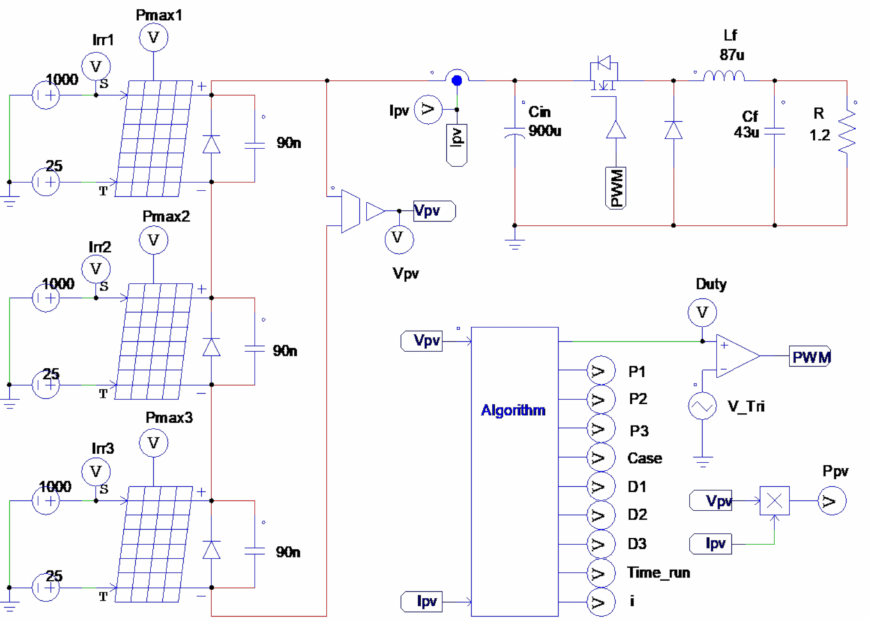
Figure 7. The buck converter used to implement the MPPT.